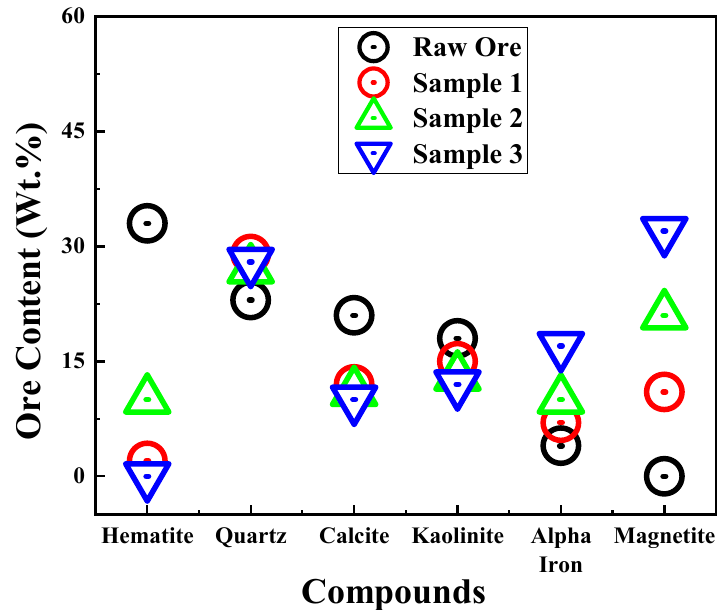
Figure 8. Rietveld analyses of 3 different samples after reduction reaction.